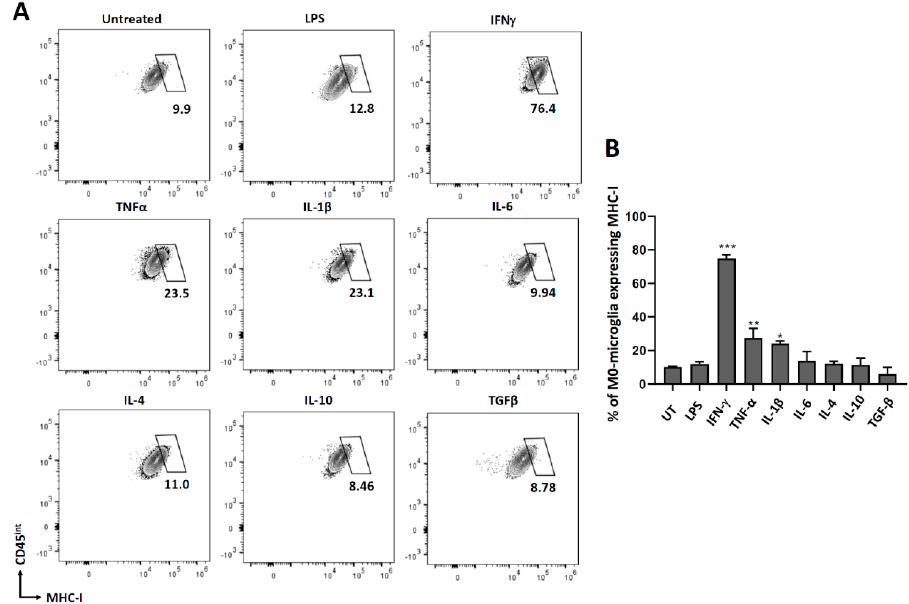
Figure 3. MHC-I expression on non-polarized (M0) microglial cells. Microglia were treated with pro- and anti-inflammatory mediators for 72 h, trypsinized, and stained for MHC-I. ( A ) Representative contour plots showing microglial cells (CD45 int ) expressing MHC-I. ( B ) Graphical representation of MHC-I expression after 72 h of treatment. UT-untreated control. Experiments were carried out three times with duplicate wells. * p < 0.05; ** p < 0.01; *** p < 0.001.